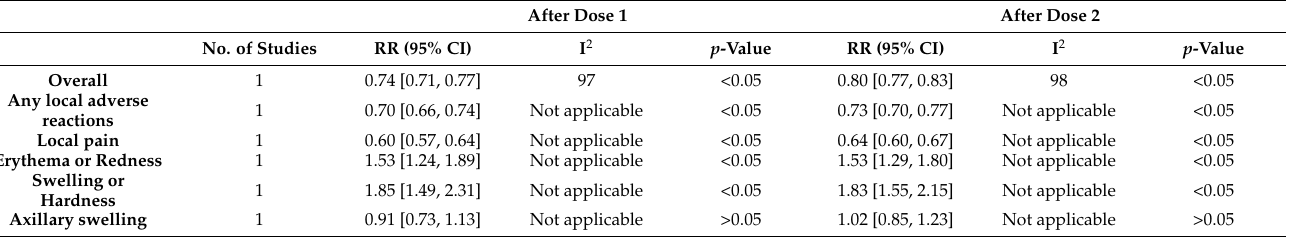
Table 7. Specific adverse reactions in mRNA vaccine recipients aged 6–23 months versus two to five